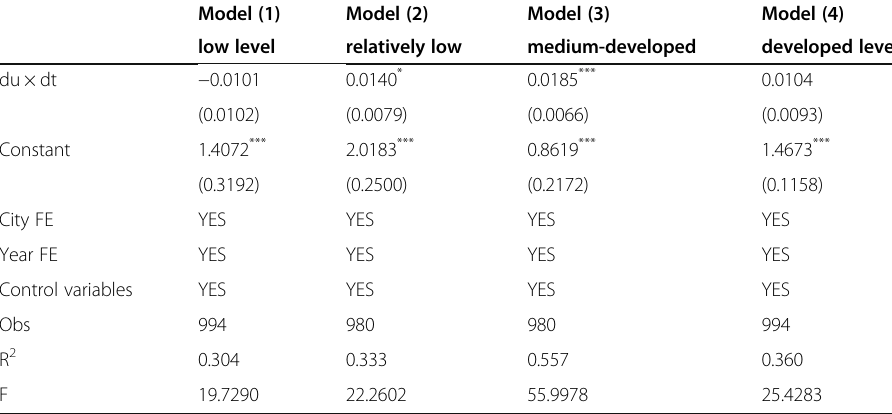
Table 8 Regression results at different levels of economic development